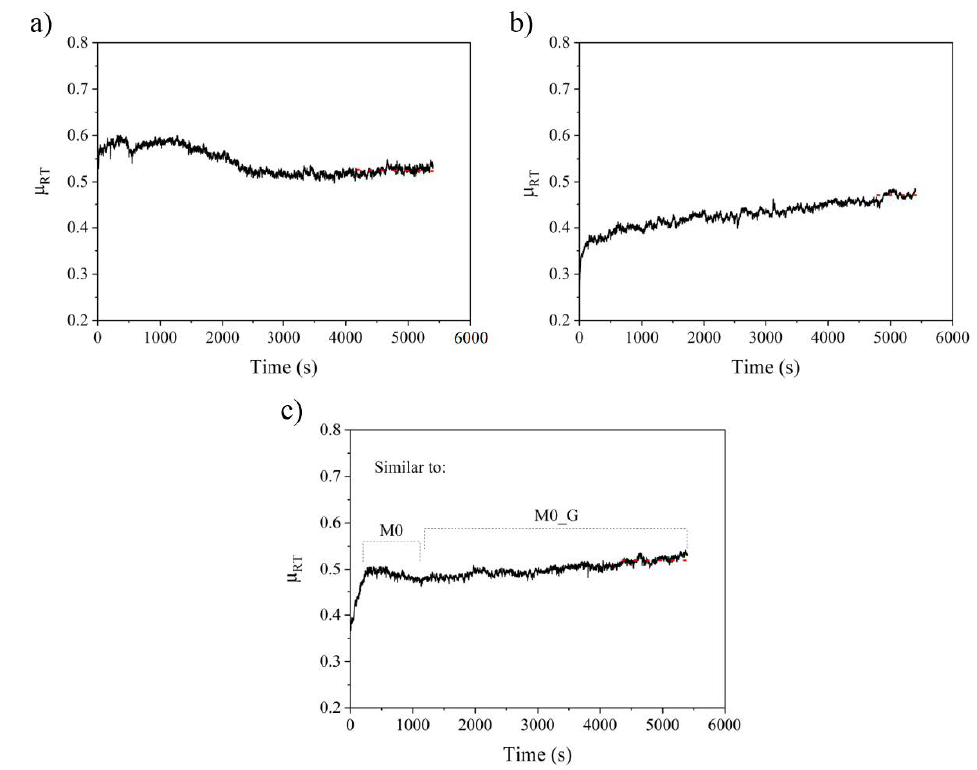
Figure 5. Evolution of the friction coefficient at RT for the ( a ) M0, ( b ) M0_G and ( c ) M0_CN samples. The red, dotted parts of the curves indicate the relevant steady